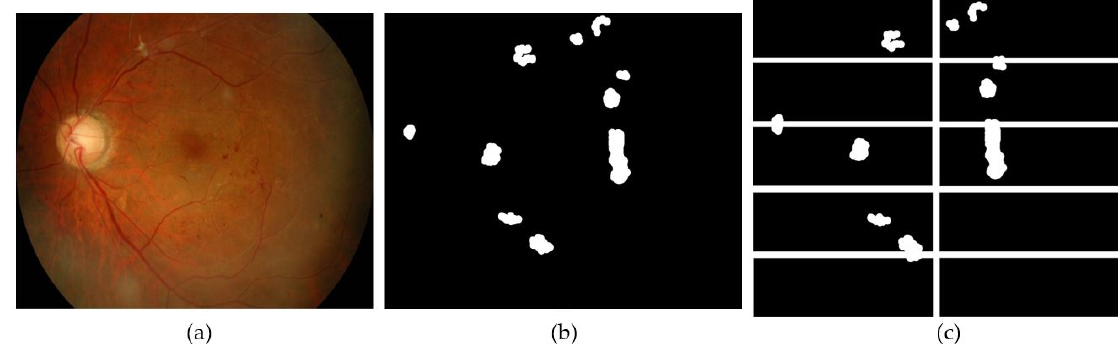
Figure 5. Ground truth cropping. ( a ) input image; ( b ) ground truth image; ( c ) ground truth was cropped into patches with each pixel corresponding to the image patches’ pixels in Figure 4e.